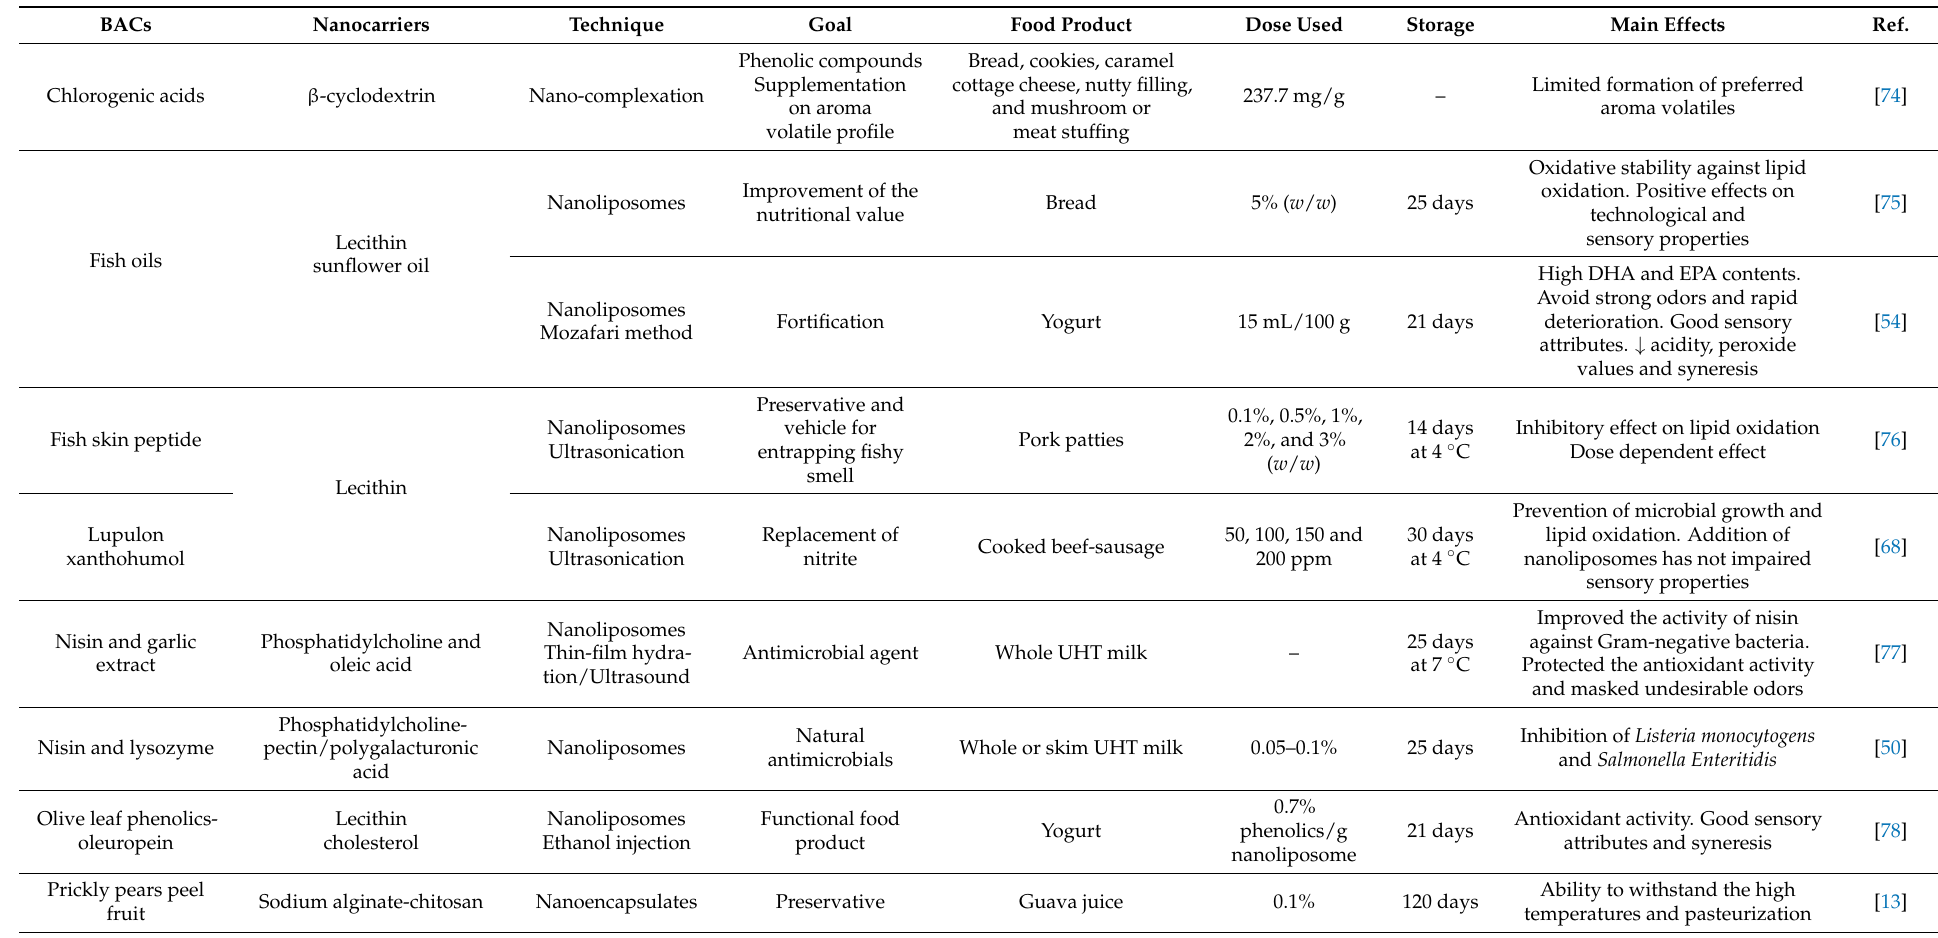
Table 4. Application of nanoencapsulated bioactive ingredients into food